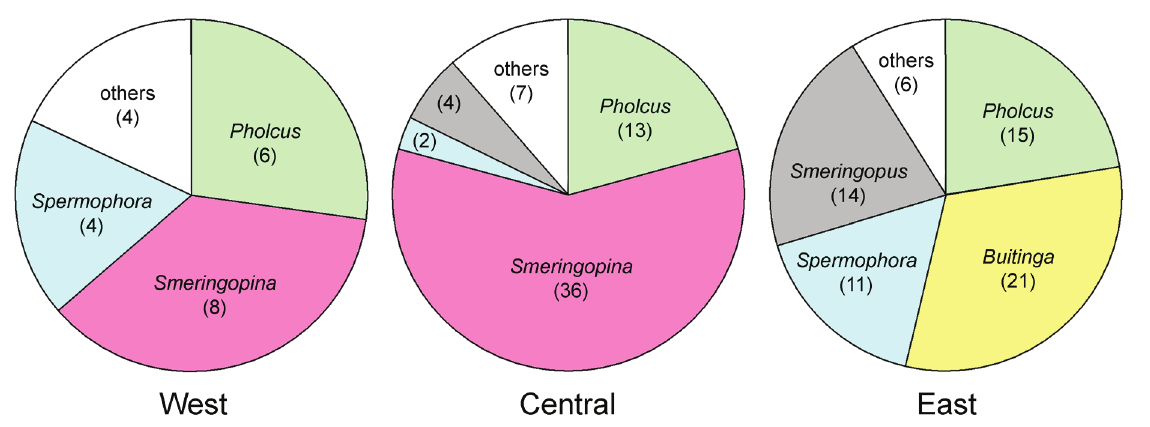
Fig. 108. Pholcid genera represented by endemic species (total numbers of endemic species in parentheses) in each region (West, Central, and East Africa), illustrating the distinctness of East Africa as compared to West and Central Africa. Data on East and West Africa from Huber & Warui (2012) and Huber & Kwapong (2013), respectively. White: genera that are not represented by more than four endemic species in any of the three